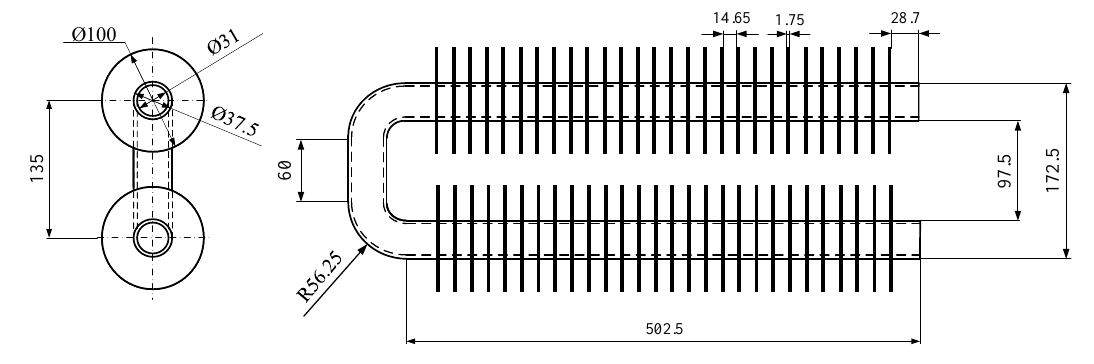
Figure 3. Dimensions of the investigated heat exchanger.